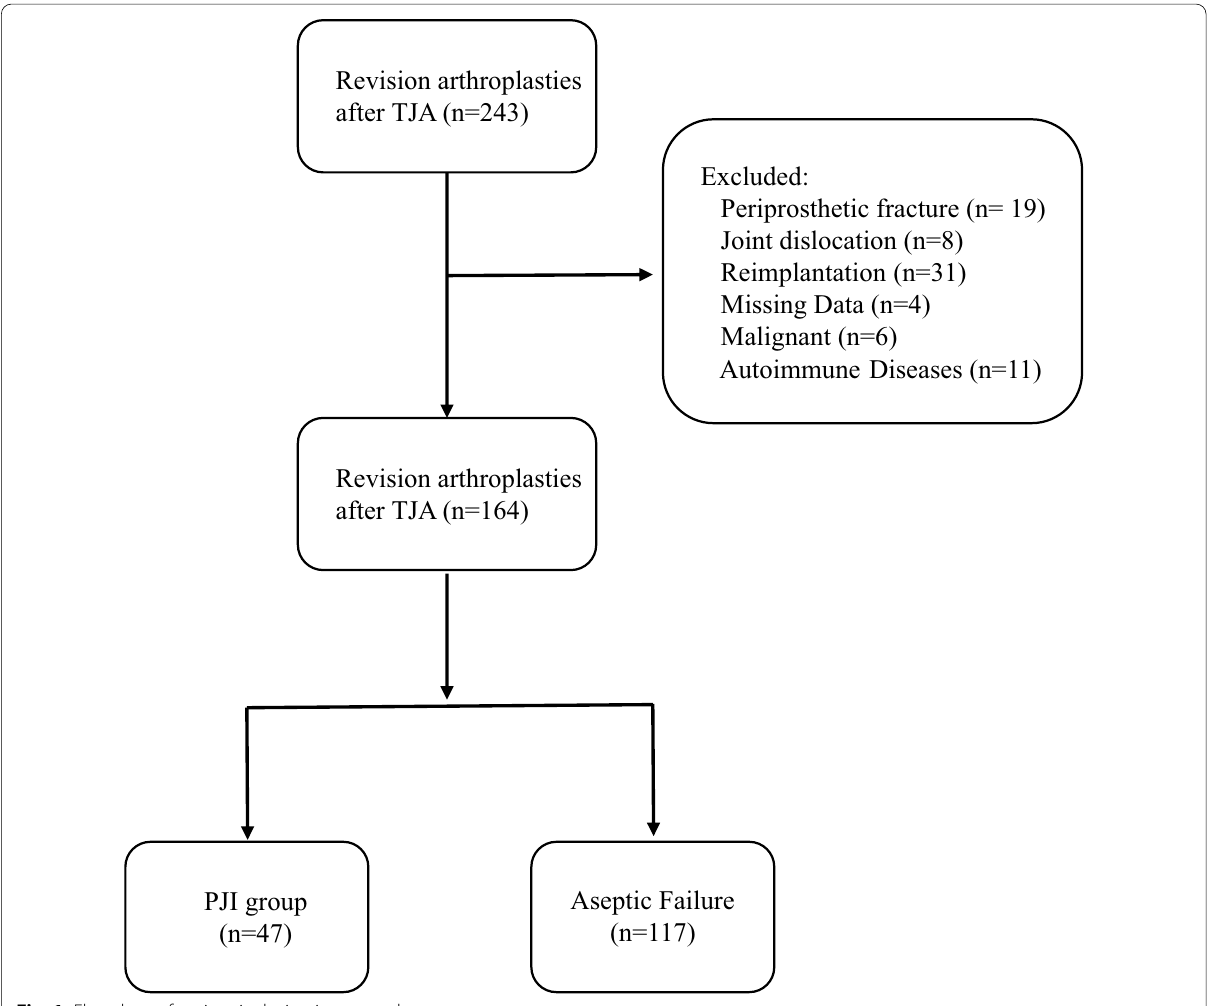
Fig. 1 Flowchart of patient inclusion in our study